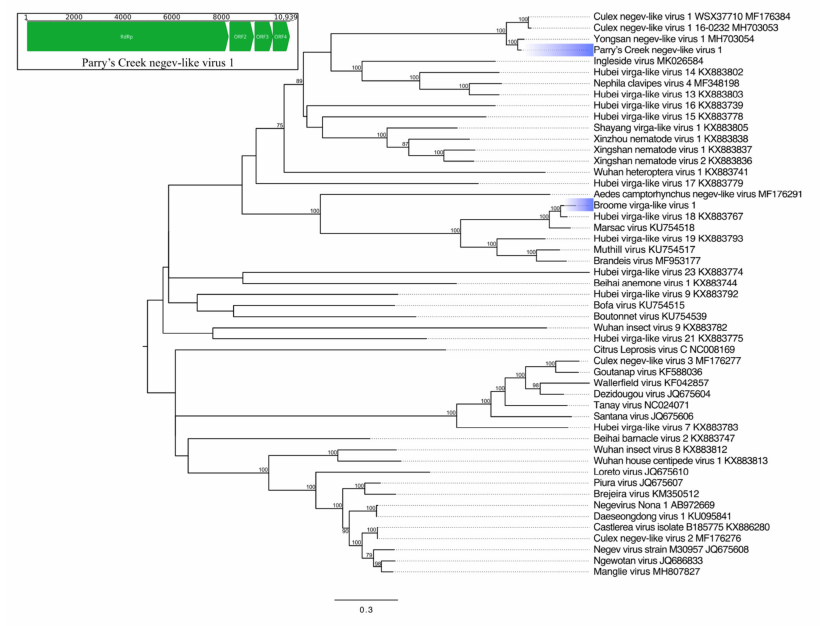
Figure 2. Phylogenetic analysis of Hepe-Virga viruses. The maximum likelihood tree was constructed using RdRp protein sequences. The scale bar represents units of substitutions per site, and bootstrap support values are displayed when greater than 70%. Viruses identified in this study are highlighted in blue. Inset: Genome organization of Parry’s Creek negev-like virus 1. Open reading frames (ORF) are indicated by green arrows, while nucleotide positions are shown above the genome. RdRp, RNA-dependent RNA